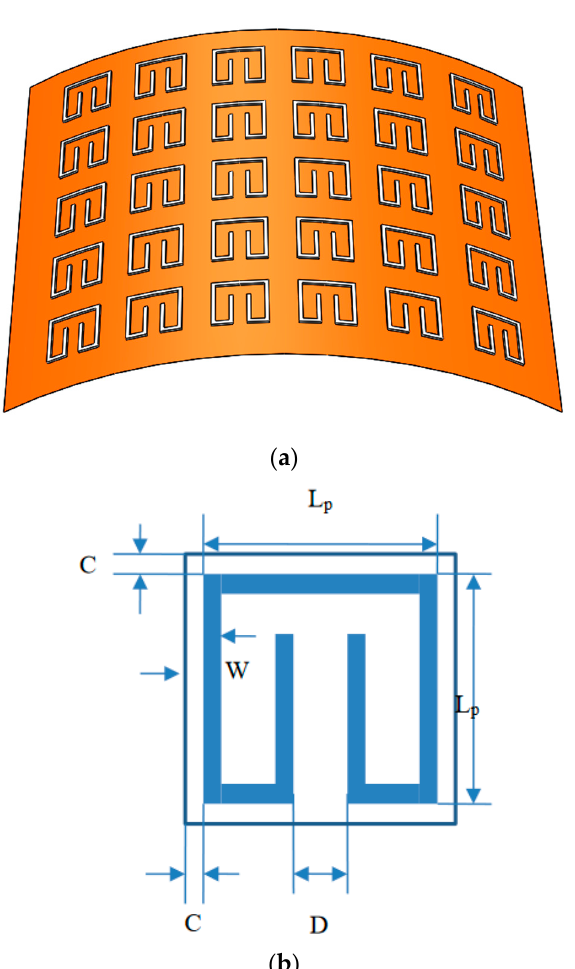
Figure 1. Flexible metamaterial structure. ( a ) Metamaterial film, ( b ) Unit cell and its dimensions.